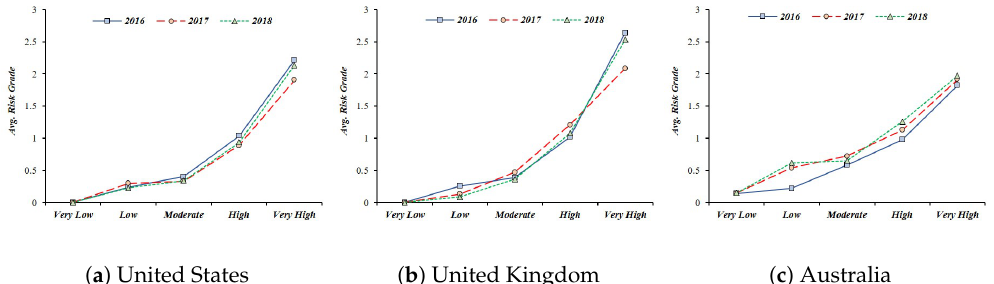
Figure 9. The average of the risk grade for Scenario 1 is relative to the policies and circumstances of each